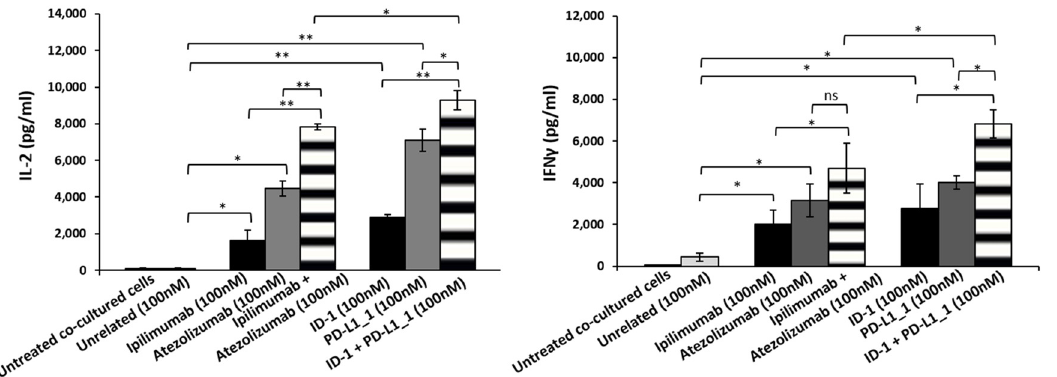
Figure 3. Effects of novel immunomodulatory mAbs on the secretion of IL-2 and IFN- γ by co-cultures of BT-549 tumor cells with hPBMCs. IL-2 and IFN- γ secretion levels were measured by ELISA on supernatants of cells treated with anti-CTLA-4 (black bars), anti-PD-L1 (dark grey bars) mAbs or their combination (striped bars) for 48 h. Cells untreated or treated with an unrelated IgG were used as negative controls (white and grey bars, respectively). Error bars depict means ± SD. p -values for the indicated compounds are: ** p < 0.01; * p < 0.05.